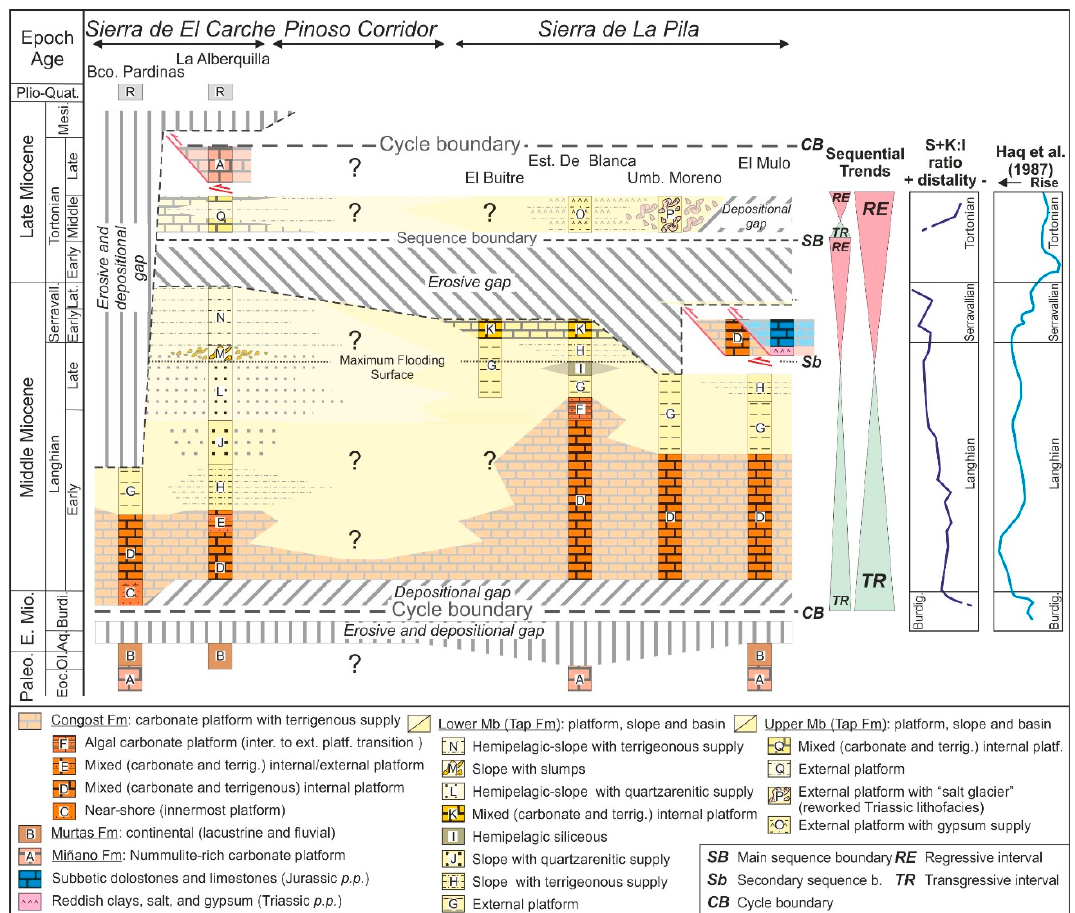
Figure 5. Stratigraphy and lateral correlation of the Neogene succession of the Pila-Carche Basin (Murcia sector) in the eastern EBZ (after Reference [20]; modified). Two stratigraphic sections have been reconstructed in the Sierra de El Carche (Barranco Pardinas and Alberquilla) and four in the Sierra de la Pila (El Buitre, Estación de Blanca, Umbría de Moreno and Pista del Mulo). The correlation highlighted main and secondary sequence boundaries (SB, Sb, respectively). The erosive and depositional gaps are also detected together with the transgressive (TR) and regressive (RE) trend (separated by a maximum flooding surface). A correlation with the standard eustatic curve is also shown in the right side of the figure.